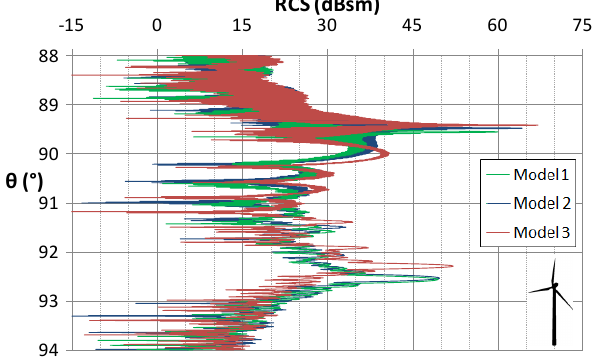
Figure 3. Vertical sections of RCS patterns ( Ф = 5º) for wind turbine models 1 to 3 at frequency 5.65 GHz. Rotor position is indicated in the lowest right corner.